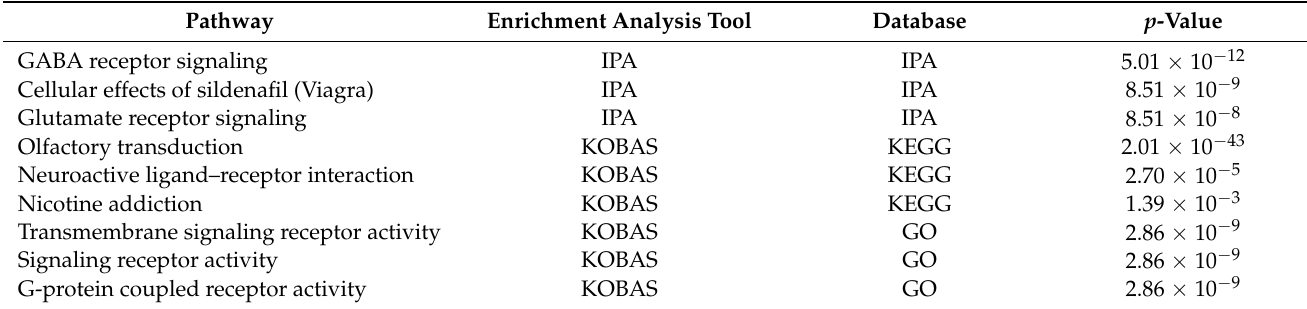
Table 4. Top three enriched pathways and GO terms, respectively, among genes with significantly lower expression in CETL samples resulting from enrichment analyses with KOBAS 3.0 and